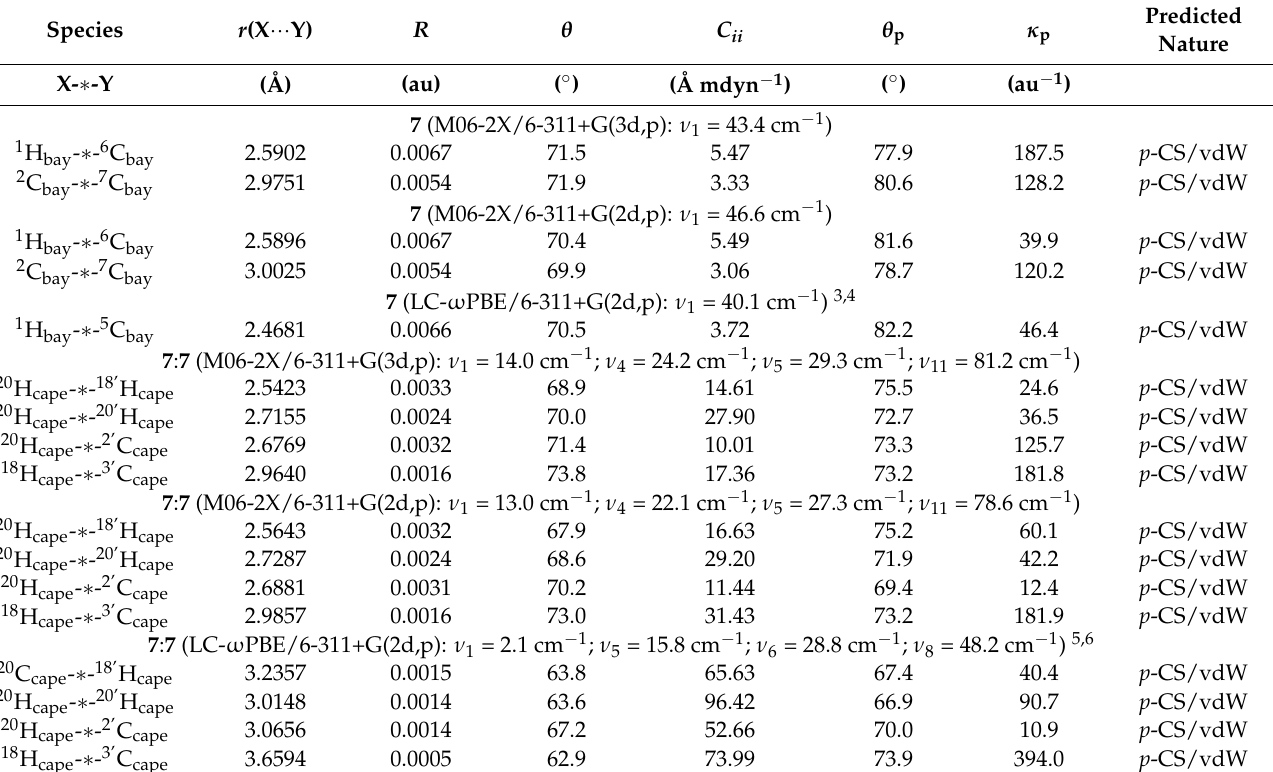
Table 3. QTAIM Functions and QTAIM-DFA Parameters Evaluated for the Fused Benzene-Type Helicene ( 7 ) and the Concave-Type Dimer ( 7 : 7 ), Employing the Perturbed Structures Generated with CIV, together with the X- ∗ -Y Distances and the Corresponding Internal Vibrations, with the Frequencies Closely Related to the Interactions in Question 1,2